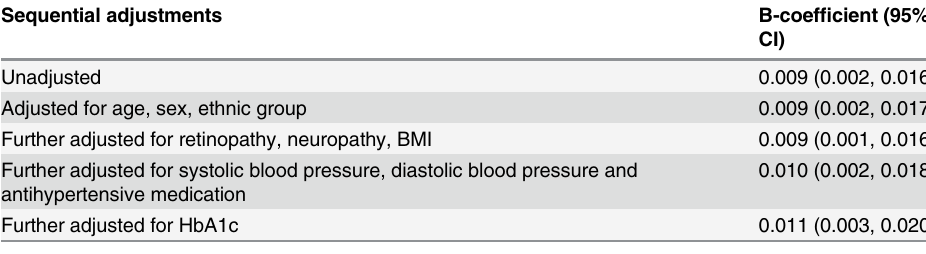
Table 4. Linear regression analysis of the association between cognitive impairment and simple total tortuosity. Sequential